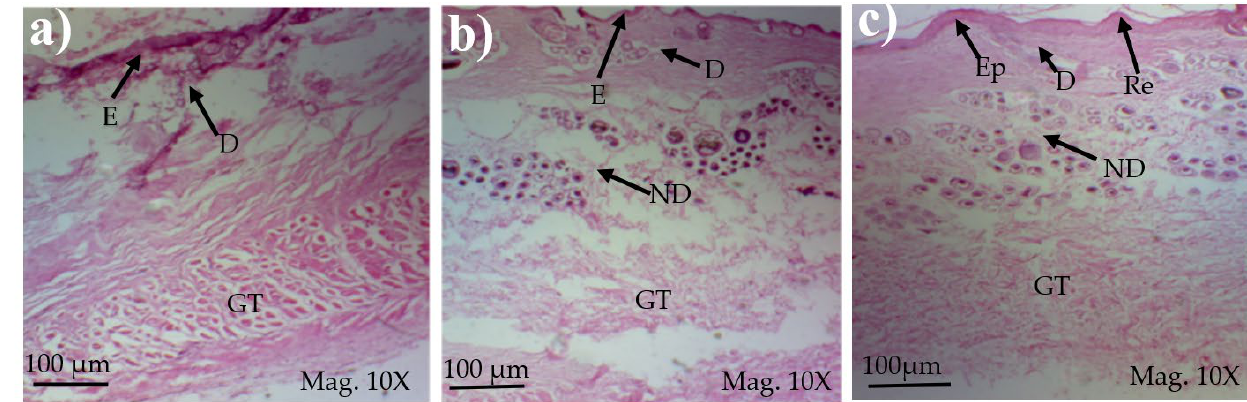
Figure 5. Healed Wound tissue treated with ( a ) Control; ( b ) Standard and ( c ) nanoemulsion, re-epithelialization (Ep) regeneration edge (Re), epidermis (E), dermis (D), normal dermis (ND) and granulation tissue (GT).